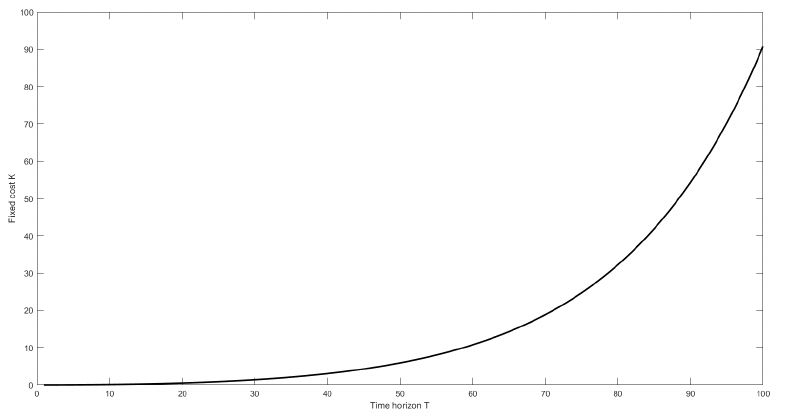
Figure 4. The effect of the time horizon T on K ∗